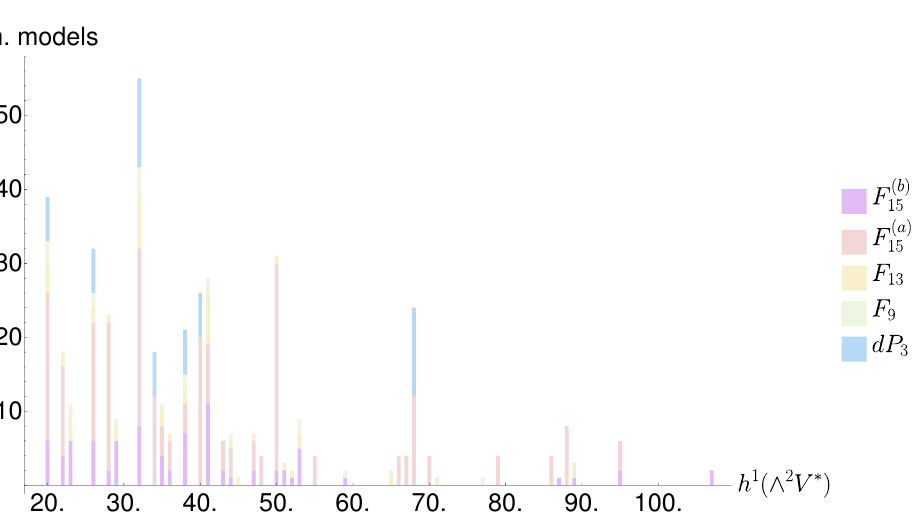
Figure 2 . Frequency plot of h 1 ( V (cid:3) ) which gives the number of 10 multiplets, combined for all base spaces.